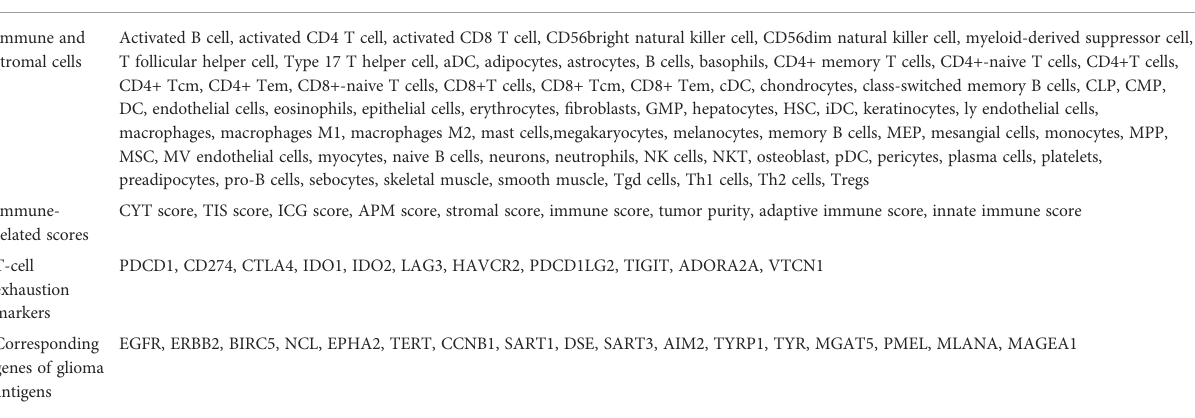
TABLE 1 List of 109 immune signatures collected in this